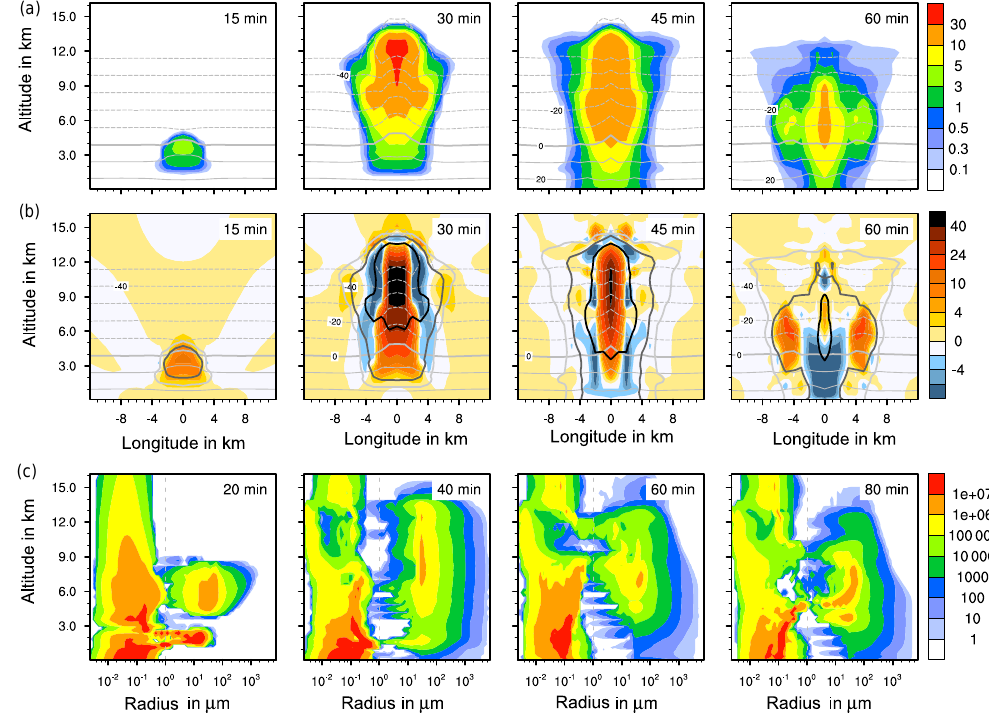
Figure 3. (a, b) Temporal development of two parameters in the warm test case shown in a vertical cut through the cloud center. Horizontal dashed lines: temperature in ◦ C. (a) Liquid water content in gkg − 1 ; (b) vertical velocity in ms − 1 . Solid lines in (b) are contour lines of the total water content: 10 (black), 1 (dark gray), and 0.1gkg − 1 (light gray). (c) Temporal development of aerosol and drop size spectra in the center cell of the cloud. Number concentrations per m 3 .